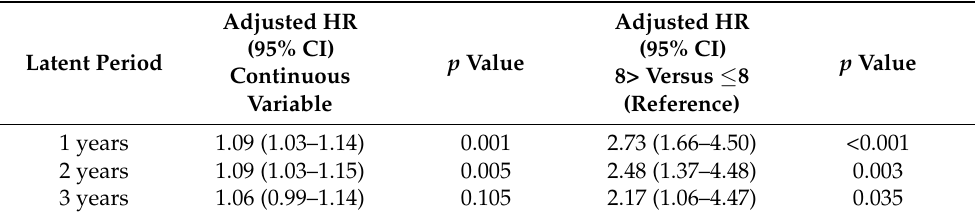
Table 4. Risk of intra-abdominal SPMs following abdominopelvic CT scans according to the latent